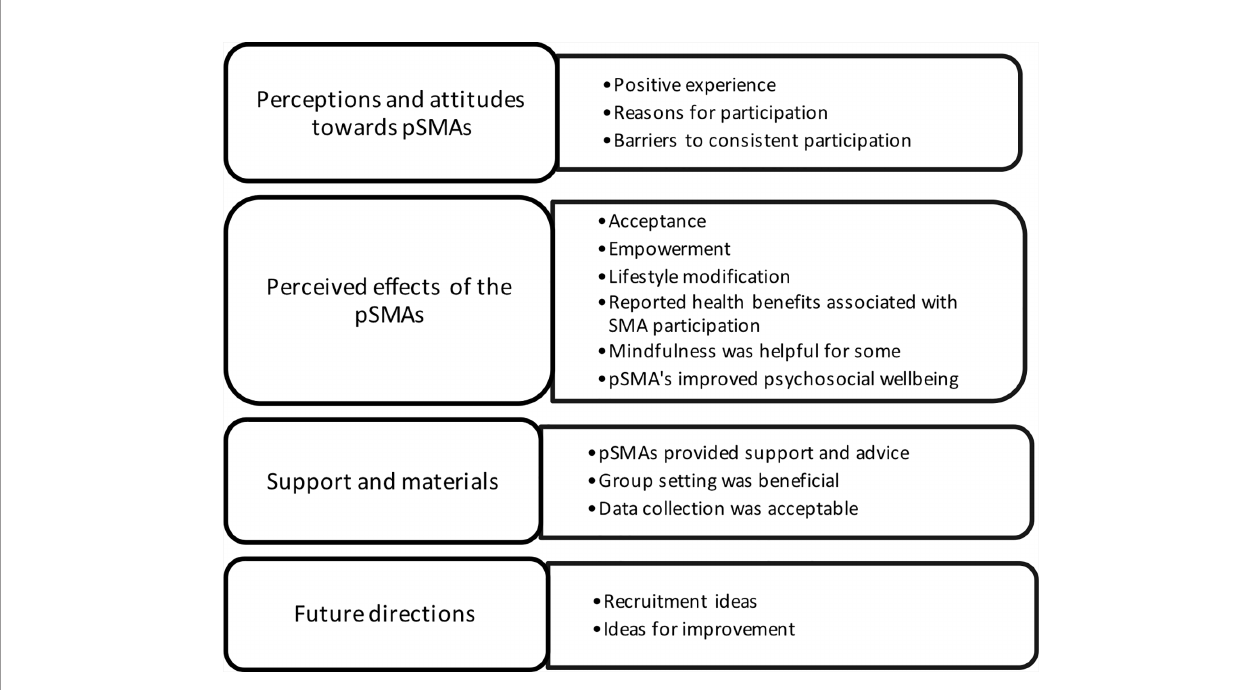
FIGURE 2 | Themes and subthemes from qualitative evaluation. pSMAs, programmed Shared Medical